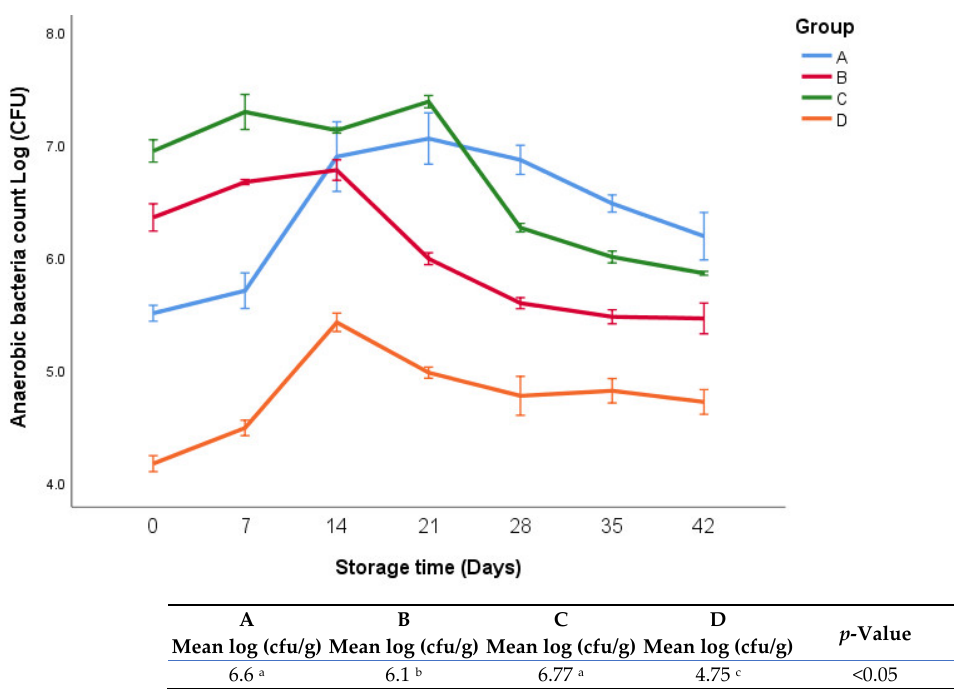
Figure 4. Anaerobic bacterial count of fresh oregano at refrigerator temperature 4 °C. The significant differences ( p < 0.05) between means are indicated in different letters in the same row. The effect of treatments was pooled to consider the whole storage period and the means were separated by Duncan test. The growth of psychrotrophic bacteria in fresh oregano leaves at refrigerator temper- ature 4 °C is shown in Figure 5. It was clear that group D exhibited significantly lower psychrotrophic bacterial count during the whole period of storage than the other groups. There were moderately significant differences between groups A and B (4.5 vs. 4.9, p < 0.05), respectively. Group C exhibited a significantly higher psychrotrophic bacterial count than group A (5.2 vs. 4.5, p < 0.05), respectively.